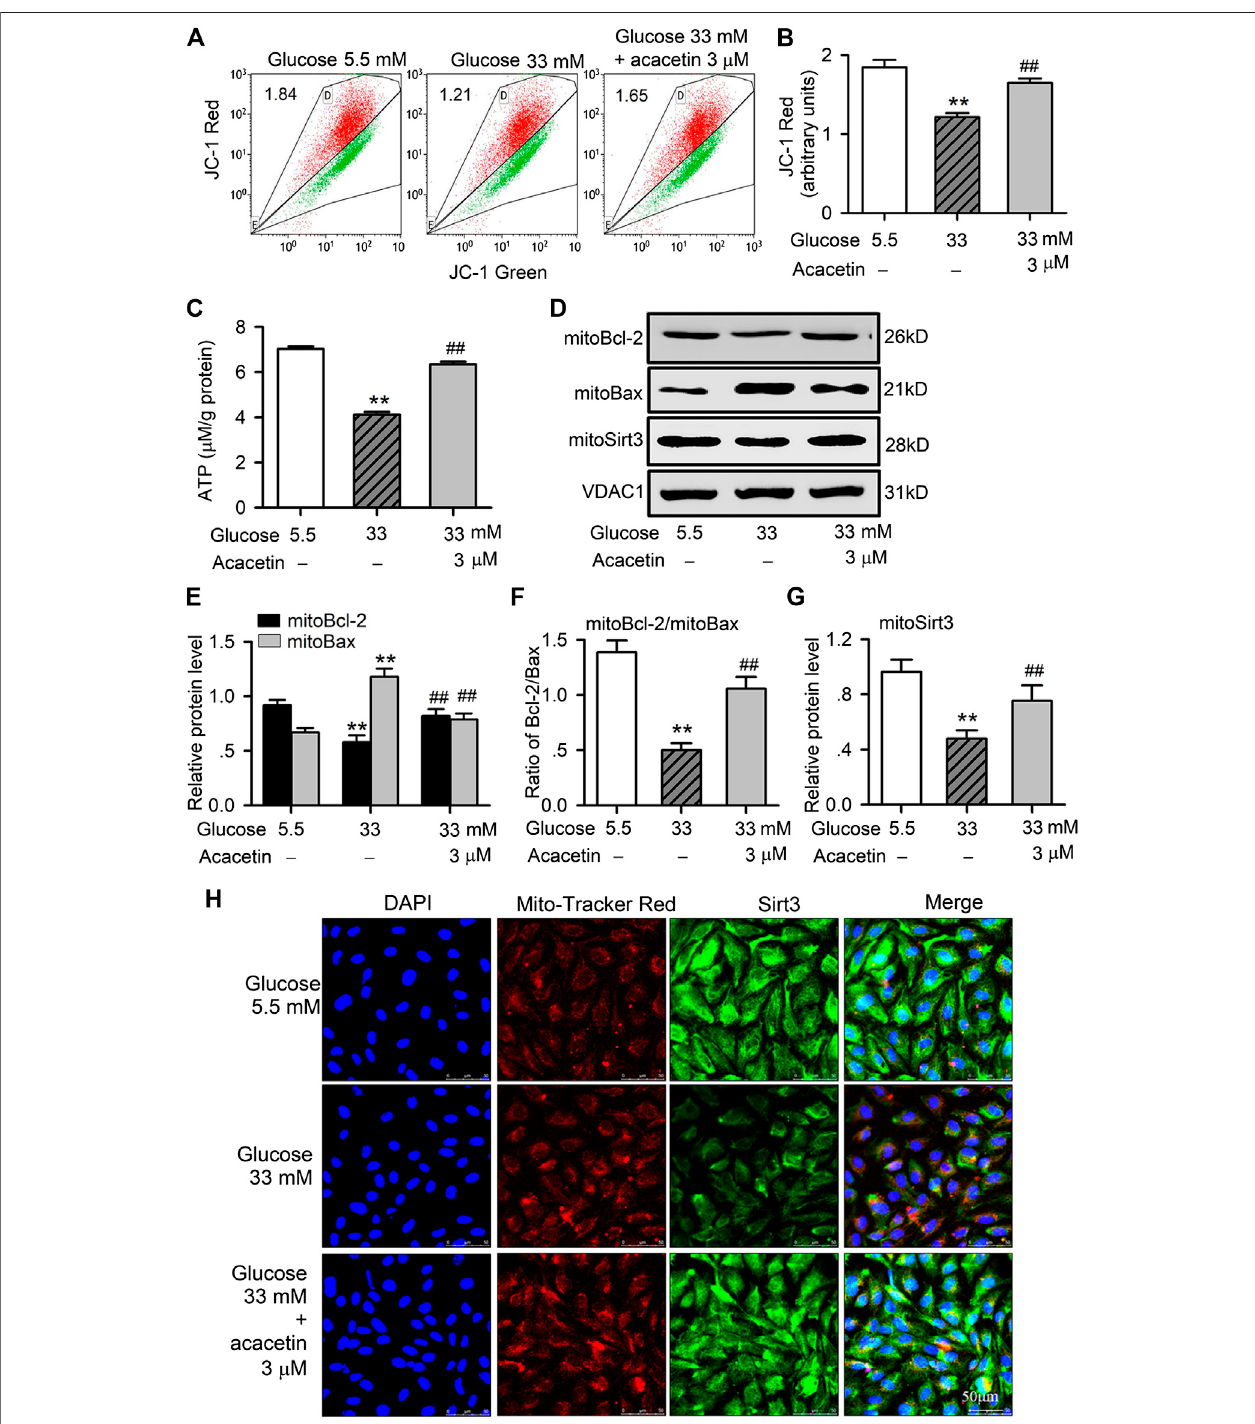
FIGURE3| ProtectiveeffectsofacacetinagainstmitochondrialdysfunctionandinjuryinducedbyhighglucoseexposureinHUVECs. (A) Flowcytometrygraphsfor determining mitochondrial transmembrane potential in HUVECs cultured with 5.5 mM glucose medium, 33 mM glucose medium or 33 mM glucose medium plus 3 μ M acacetin. (B) Acacetin reversed the decrease in mitochondrial transmembrane potential in cells with high glucose exposure. (C) Acacetin countered high glucose- induced decrease in ATP production. (D) Western blots of mitochondrial Bcl-2, Bax, and Sirt3 in cells cultured with 5.5 mM glucose medium, 33 mM glucose medium or 33 mM glucose medium plus 3 μ M acacetin. (E) Relative (to VDAC1, voltage-dependent anion channel 1) mitochondrial Bcl-2 and Bax protein levels in cells culturedwith5.5 mMglucosemedium,33 mMglucosemediumor33 mMglucosemediumplus3 μ Macacetin. (F) Acacetinreversedthereducedratioofmitochondrial Bcl-2/Bax proteins. (G) Acacetin reversed the high glucose-induced reduction of Sirt3 protein. (H) Sirt3 immunocytochemical staining and mitoTracker Red co-staining ( × 80 magni fi cation) of HUVECs cultured with 5.5 mM glucose medium, 33 mM glucose medium or 33 mM glucose medium plus 3 μ M acacetin. n (cid:2) 5 individual experiments, ** p < 0.01 vs. 5.5 mM glucose; # p < 0.05, ## p < 0.01 vs. 33 mM glucose.